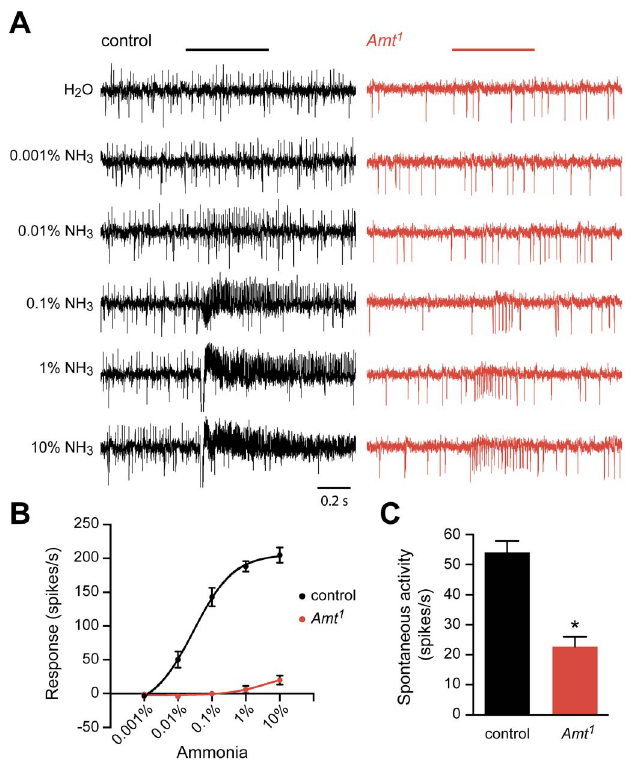
Figure 5. Reduced response of ac1 sensilla to ammonia in Amt. (A) Extracellular recordings of neuronal responses to a 500 ms pulse of either water or ammonia from ac1 sensilla of control and Amt 1 . ac1 sensilla were identified by their location and response characteristics (see Materials and Methods). Ammonia responses were quantified by subtracting the spike frequency elicited by water (solvent) from that elicited by ammonia and are plotted in (B). (C) The spontaneous spiking activity in ac1 sensilla was significantly lower in Amt 1 mutant sensilla compared to controls (n=9 each, p , 0.0001).